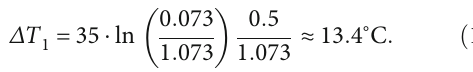
Borehole trajectory according to measurements by contractor No. 1 Borehole trajectory according to measurements by contractor No. 2 Tolerance circle of deviation from the vertical ( R = 0.6 Figure 10: An example of errors of the borehole deviation survey for freezing and TC